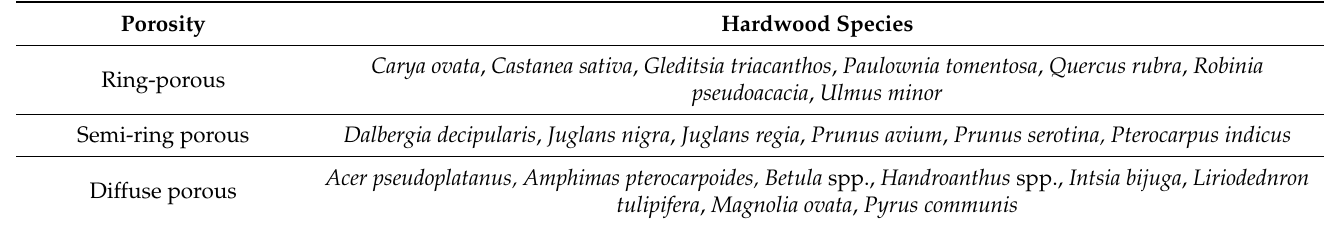
Table 8. Examples of species for different types of porosity in